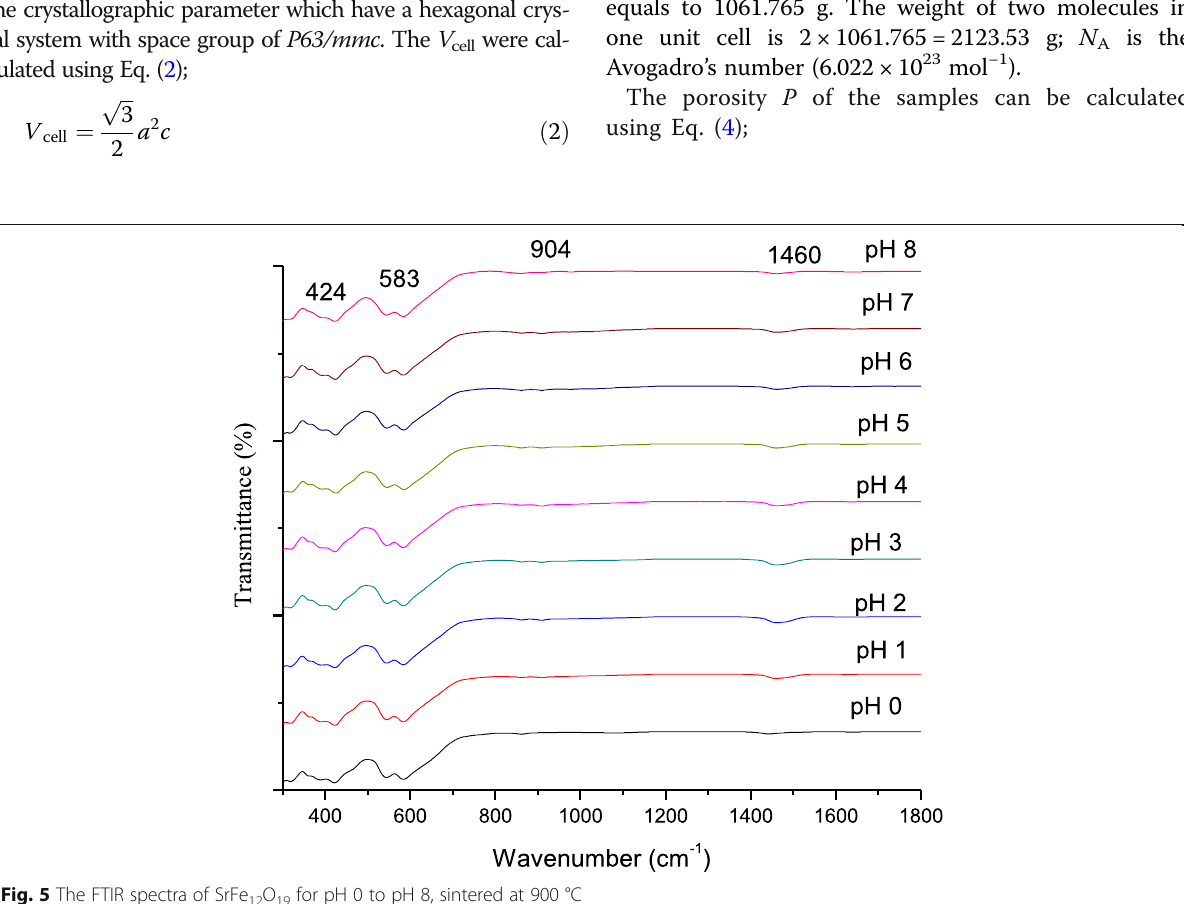
Fig. 5 The FTIR spectra of SrFe 12 O 19 for pH 0 to pH 8, sintered at 900